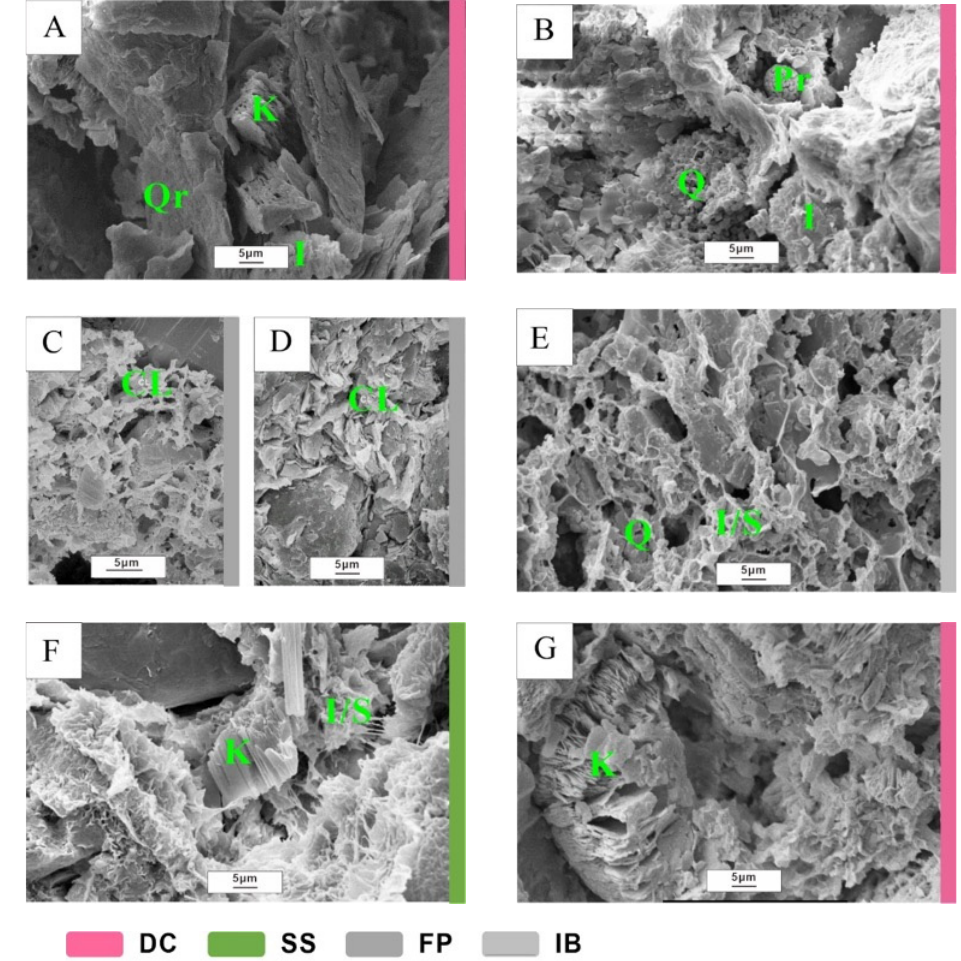
Figure 18. SEM images of representative clay mineral samples from the Guantao Formation. ( A ) PL25-C1, L80. The dissolution of feldspar produces intragranular pores and transforms into silky and scale kaolinite. ( B ) PL25-C, L80. Octahedral pyrite, silky illite filling intergranular pores. ( C , D ) PL19-B, L50. ( E ) PL25-3C1, L60. The filamentous illite/smectite mixed-layer was attached to the particle surface and filled the intergranular pores. ( F ) PL25-C, L100. A high number of silk-flocculent illite/smectite mixed-layer filled the intergranular pores, and some potassium feldspar particles were dissolved and transformed into book-shaped kaolinite. ( G ) PL25-C1, L80.Worm-shape kaolinite